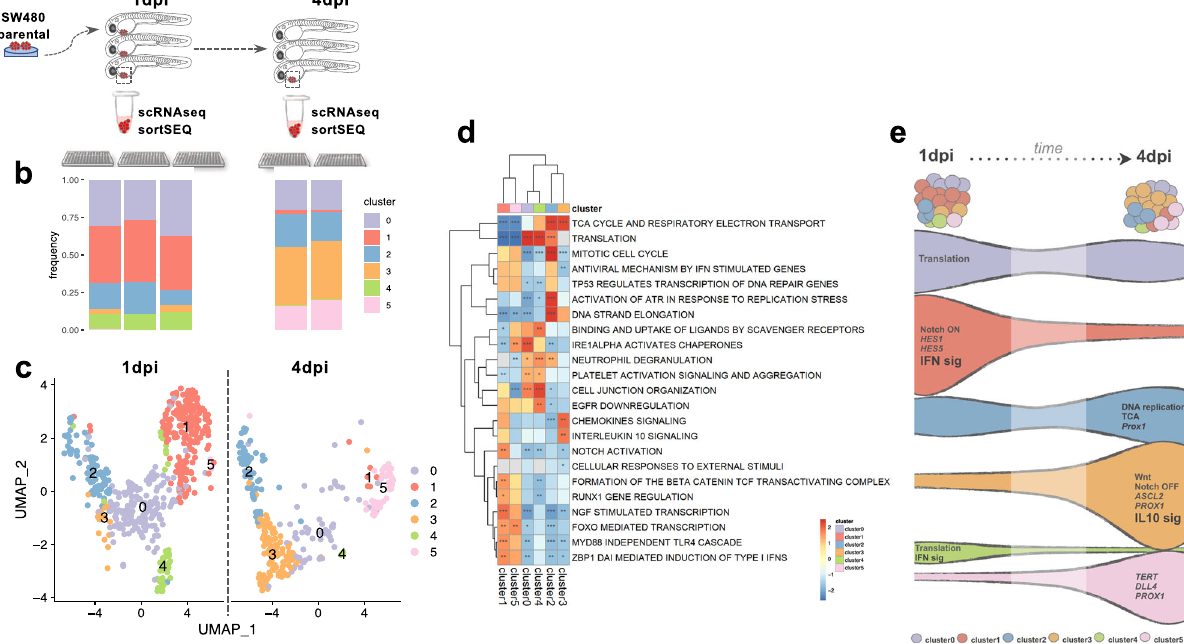
Fig. 8 Single-cell transcriptome pro fi ling reveals the clearance and expansion of different SW480 subclones. a Schematic illustration of the design of the experiment. SW480 cells were injected into 2 dpf zebra fi sh embryos, and at 1 and 4 dpi, tumors were dissected and processed for scRNAseq. b Relative frequencies of the cell clusters present in each library replicate. c Uniform Manifold Approximation and Projection (UMAP), representing the relative similarity between individual cells, colored by cell cluster and divided by timepoints 1 and 4 dpi. d Heatmap representation of normalized enrichment scores (NES) of representative pathways with statistically signi fi cant (adjusted P -value < 0.05) enrichment in gene set enrichment analysis (GSEA), comparing the gene expression of each cellular subgroup to all the others. Red colors mean that genes in that pathway tend to be more expressed in that cellular subcluster, while blue means that genes tend to be less expressed. Signi fi cant NES values are marked with asterisk (Fisher exact test *: adjusted P -value < 0.05; **: adjusted P -value < 0.01; ***: adjusted P -value < 0.001). Gray colors are cases where a NES value could not be obtained and should be considered non-signi fi cant (see Supplementary Data 2 for GSE values). e Schematic illustration of expansion/reduction of each cluster from 1 to 4 dpi with the most representative pathways and